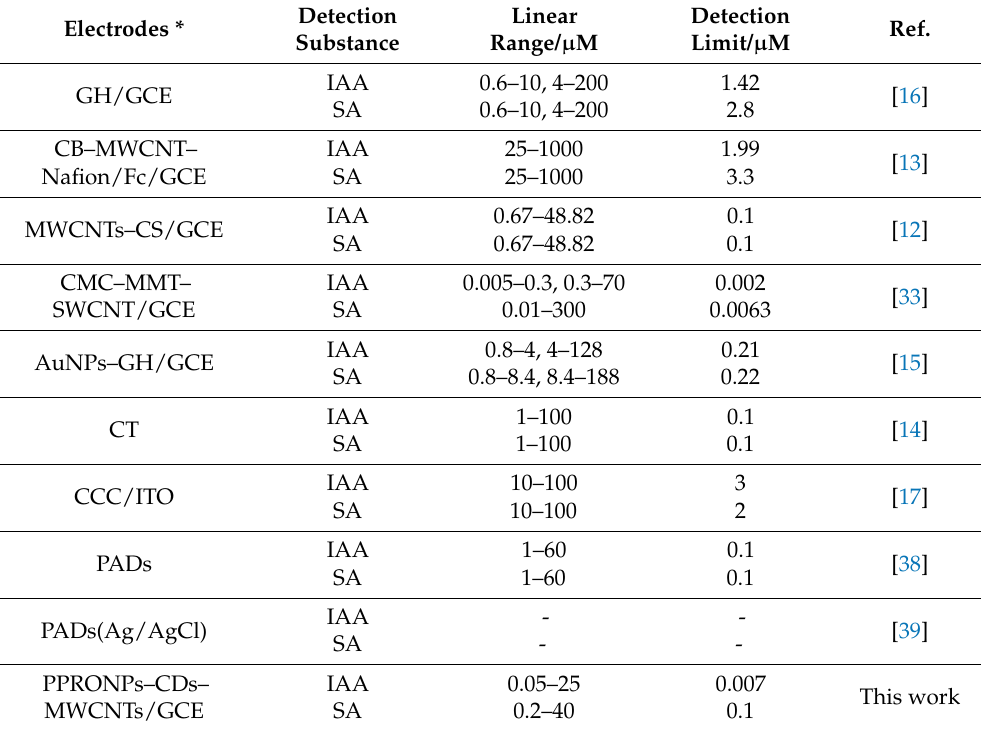
Table 2. Comparison of typical modified electrodes for determination of IAA and